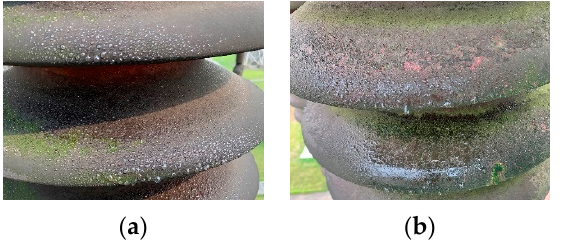
Figure 8. The hydrophobicity test results of the RTV post insulator. ( a ) Algae-free RTV surface. ( b ) Algal RTV surface.